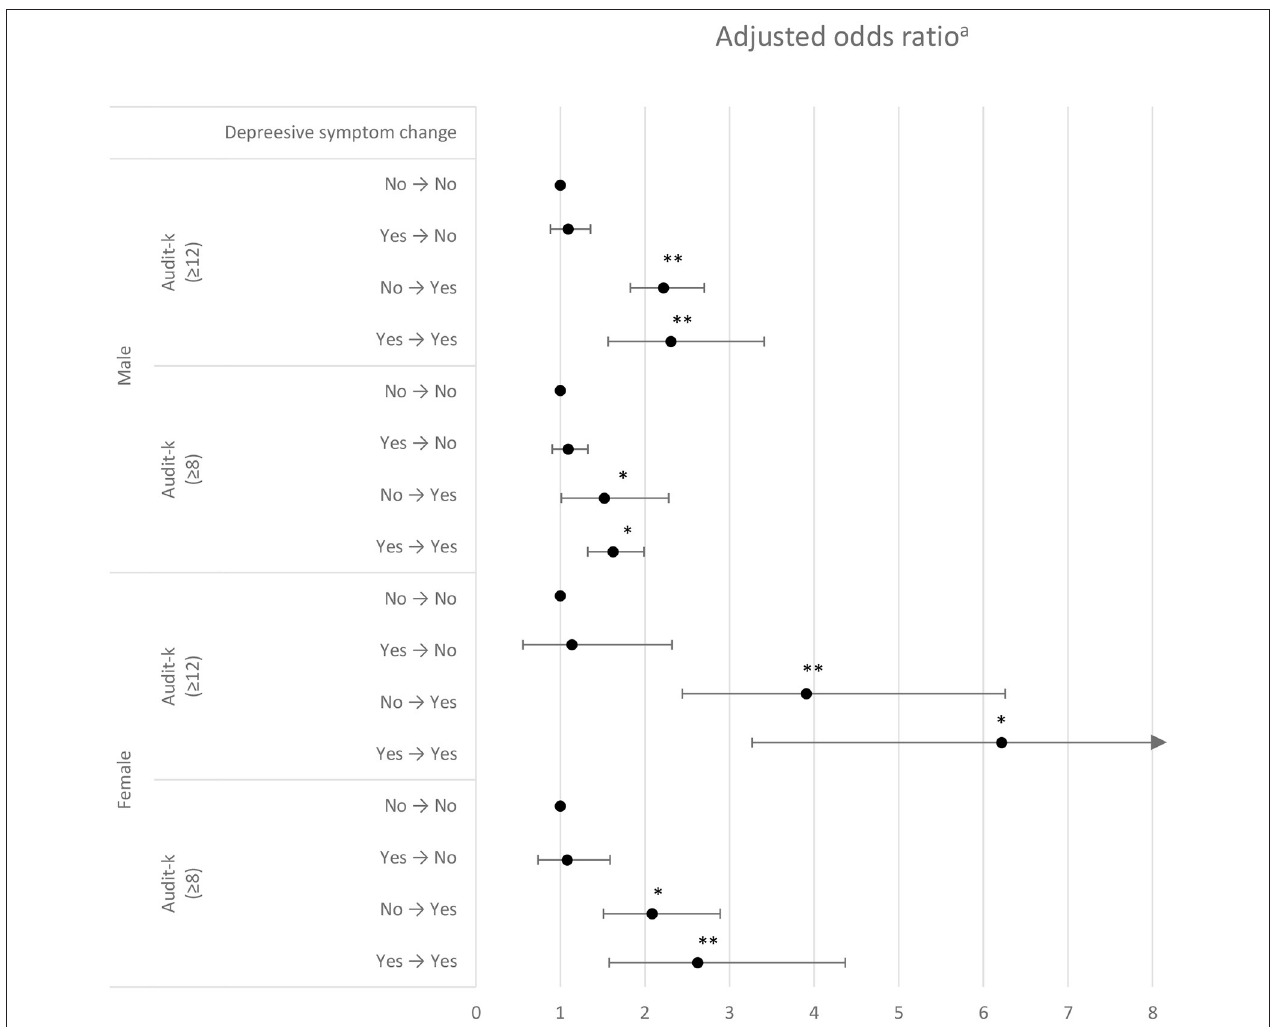
FIGURE 2 | Sensitivity analysis using the generalized estimation equation for association between changes in depressive symptoms and hazardous drinking by different criteria for defining hazardous